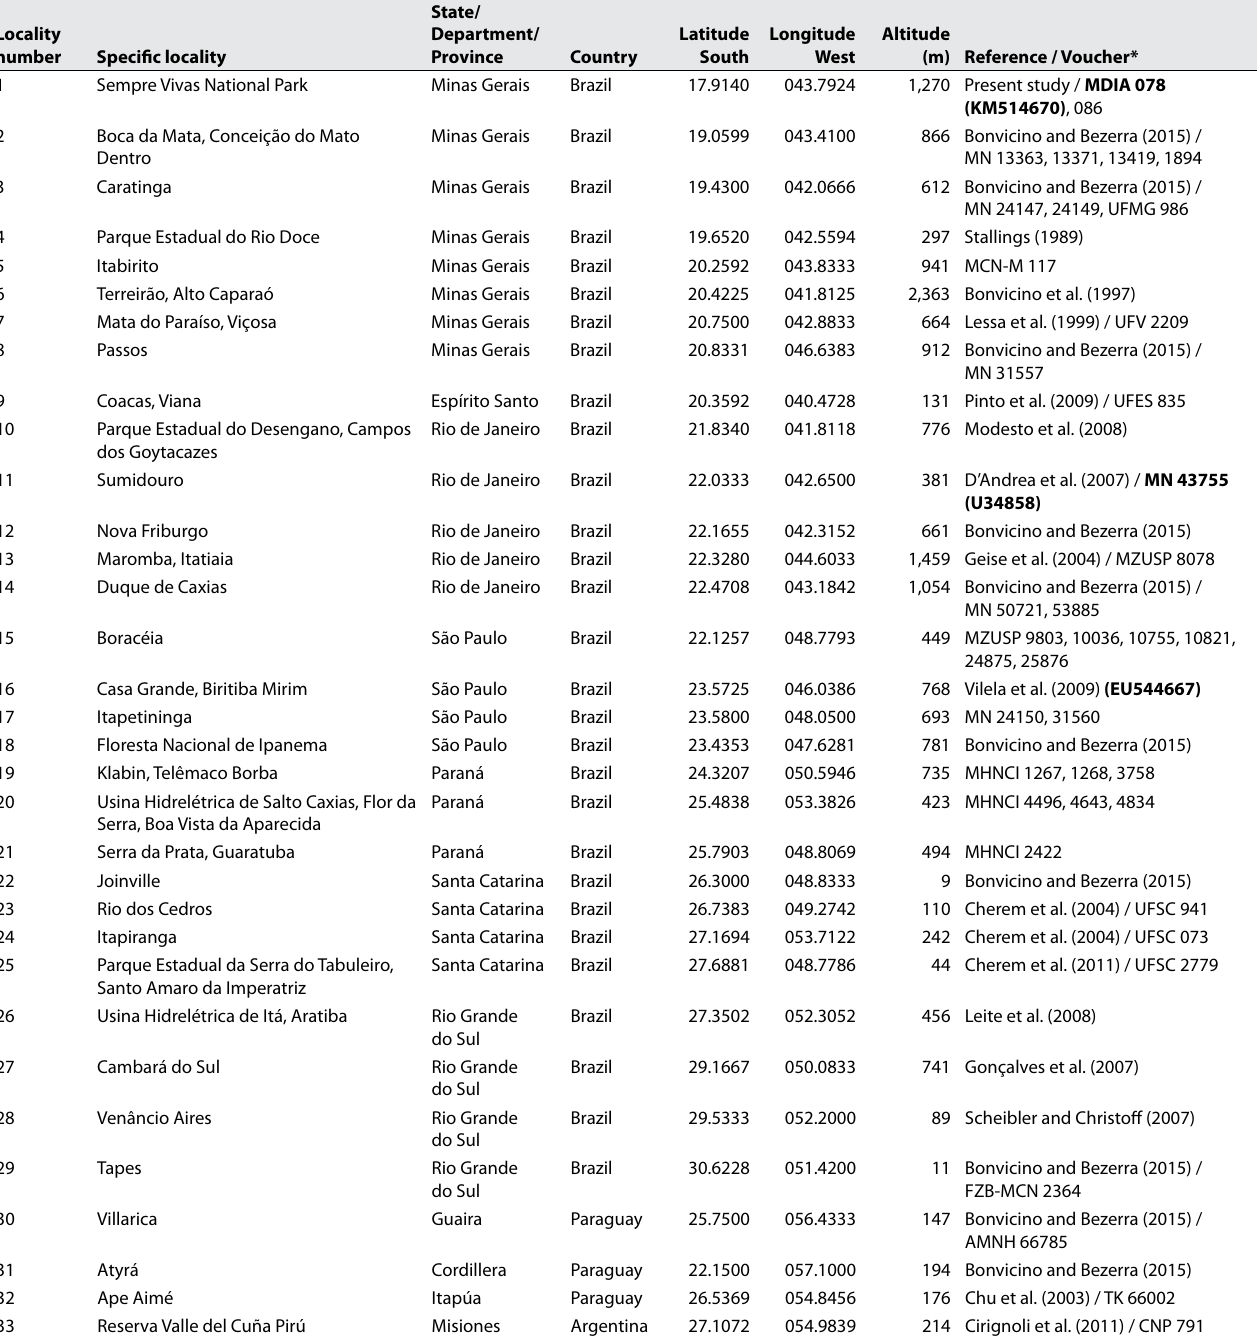
Table 2. Confirmed records of Euryzygomatomys spinosus sorted according to numbered localities mapped in Figure 5, and corresponding reference and/or voucher number (when examined). References in bold indicate species identity confirmed also by DNA analysis and corresponding Genbank accession code for cyt b sequence in